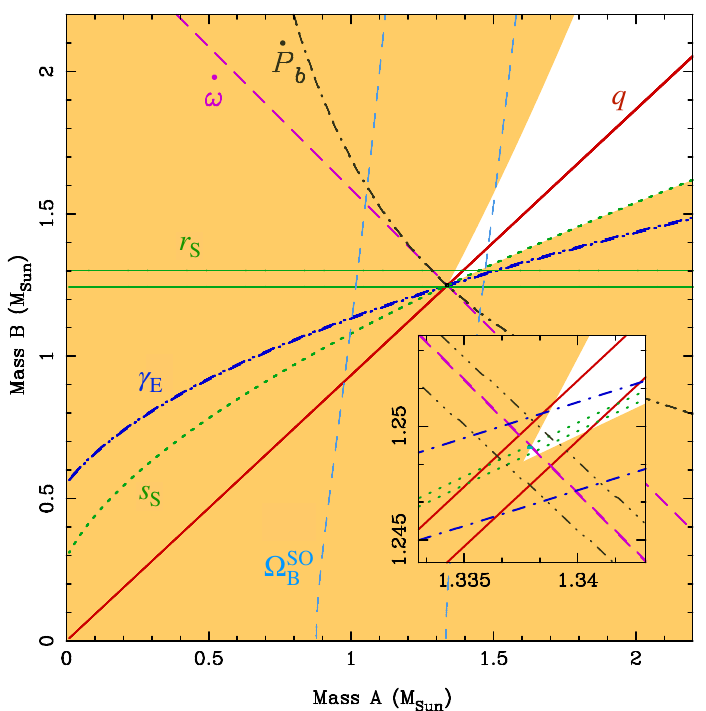
Figure 3. Mass-mass diagram for the Double Pulsar assuming GR. Each pair of curves corresponds to a measured PK parameter ( ± 1 σ ), with the exception of the mass ratio q . The corresponding equations are given in Sections 3.1–3.3. The orange regions are excluded by the fact that sin i ≤ 1. The inset clearly shows that there is a small region in the mass-mass plane which all seven PK parameters agree